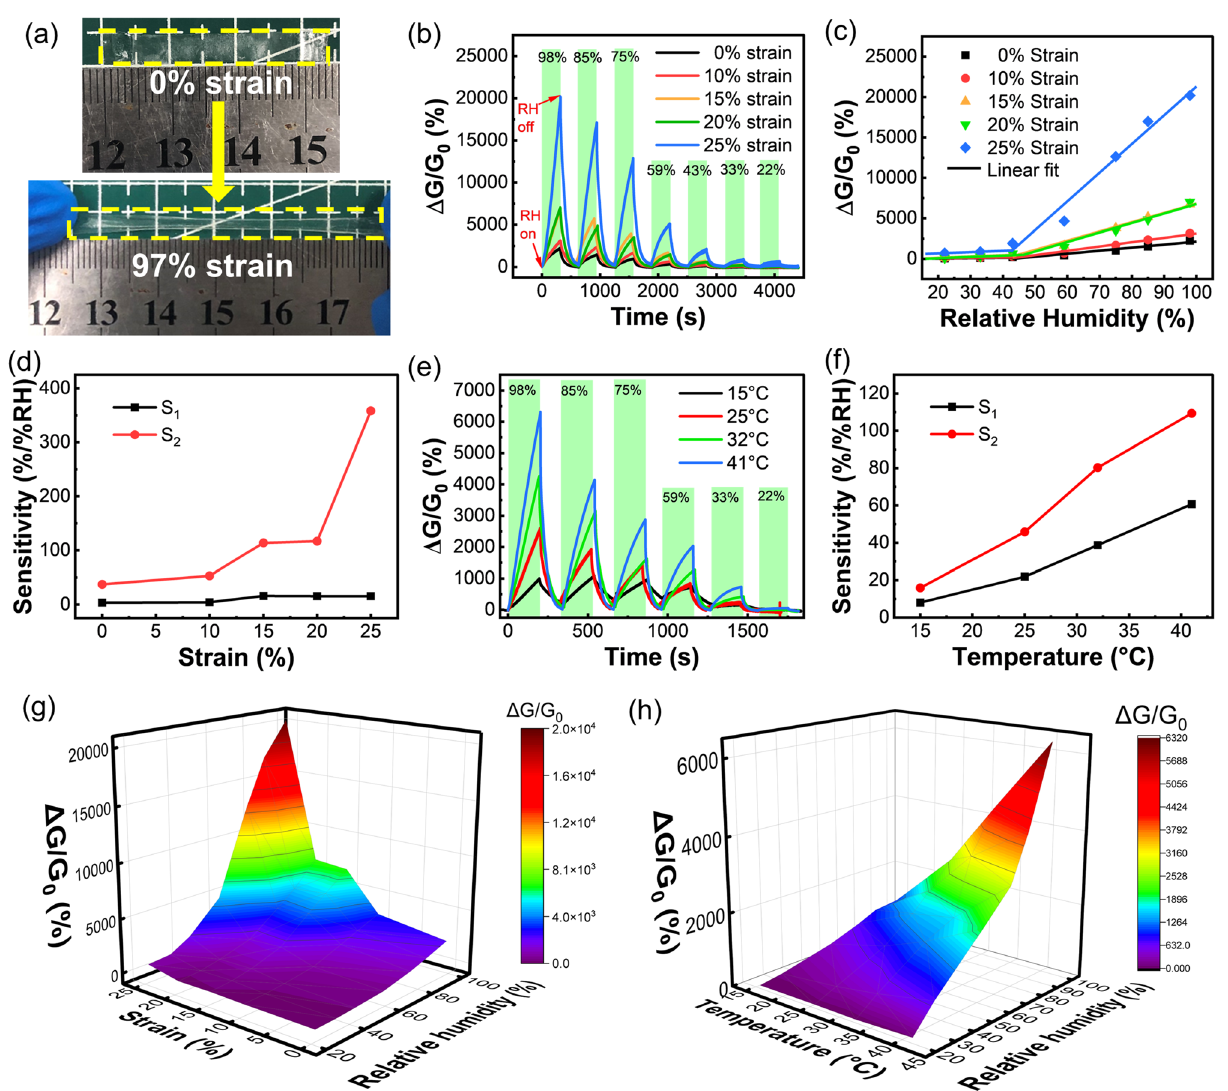
Fig. 5 a Photographs show that the hydrogel film withstands 97% tensile strain. b Dynamic response curves to different RH at 0, 10, 15, 20, and 25% tensile strains. c Piecewise fitting of the response of sensors versus RH at different strains. d The relationship between sensitivity and ten- sile strain. e Dynamic response curves to different RH at 15, 25, 32, and 41 °C. f The relationship between sensitivity and temperature. g Com- pound plots of responses of the sensor toward strain and RH. h Compound plots of responses of the sensor toward temperature and